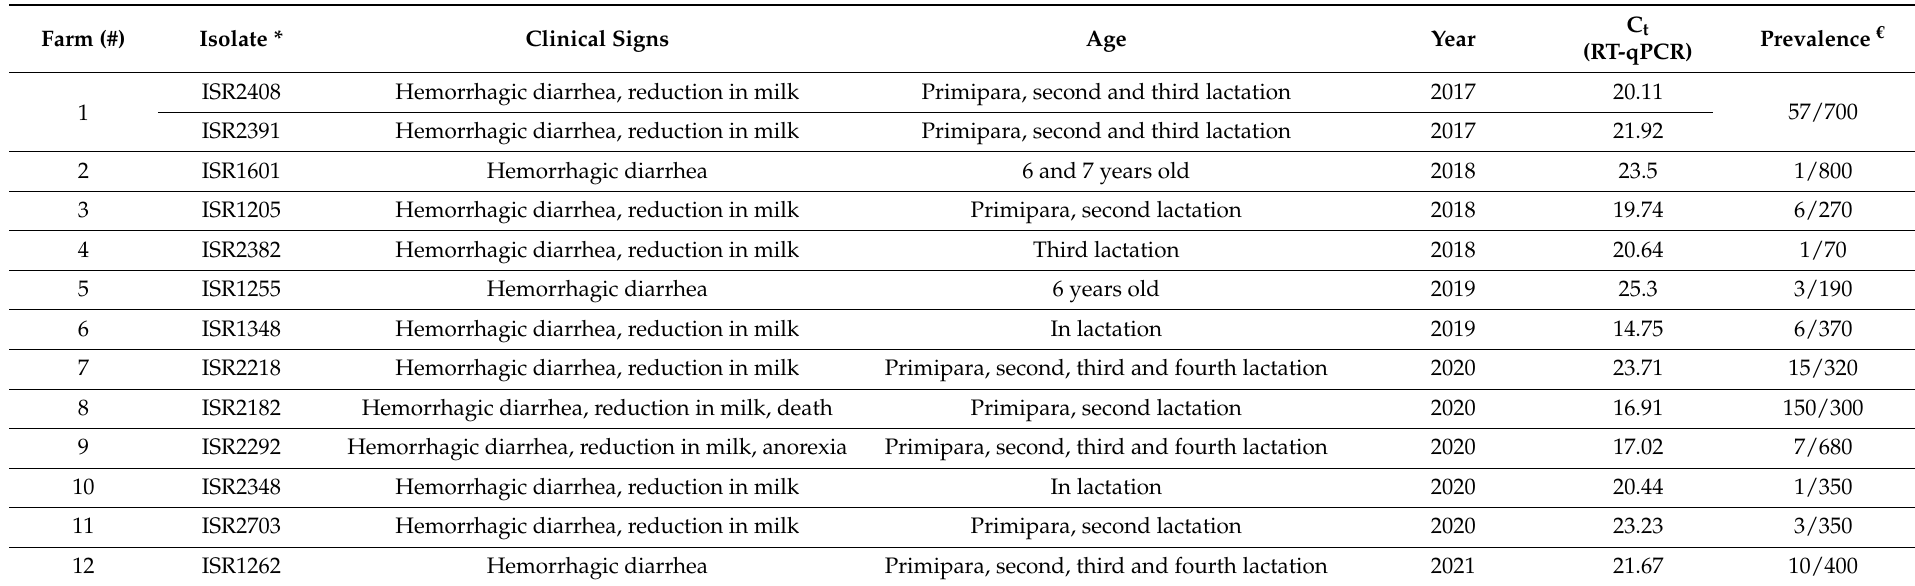
Table 1. Local Bovine Coronavirus isolated from winter dysentery-diseased